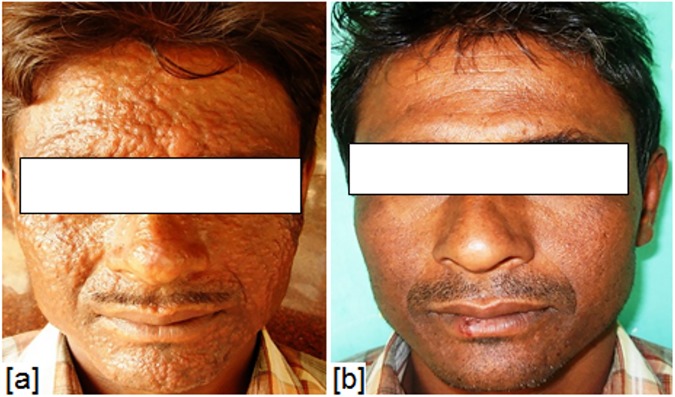
Skin lesions in a male patient- (a) before treatment, (b) after treatment with amphotericin B 0.5mg/kg/day.